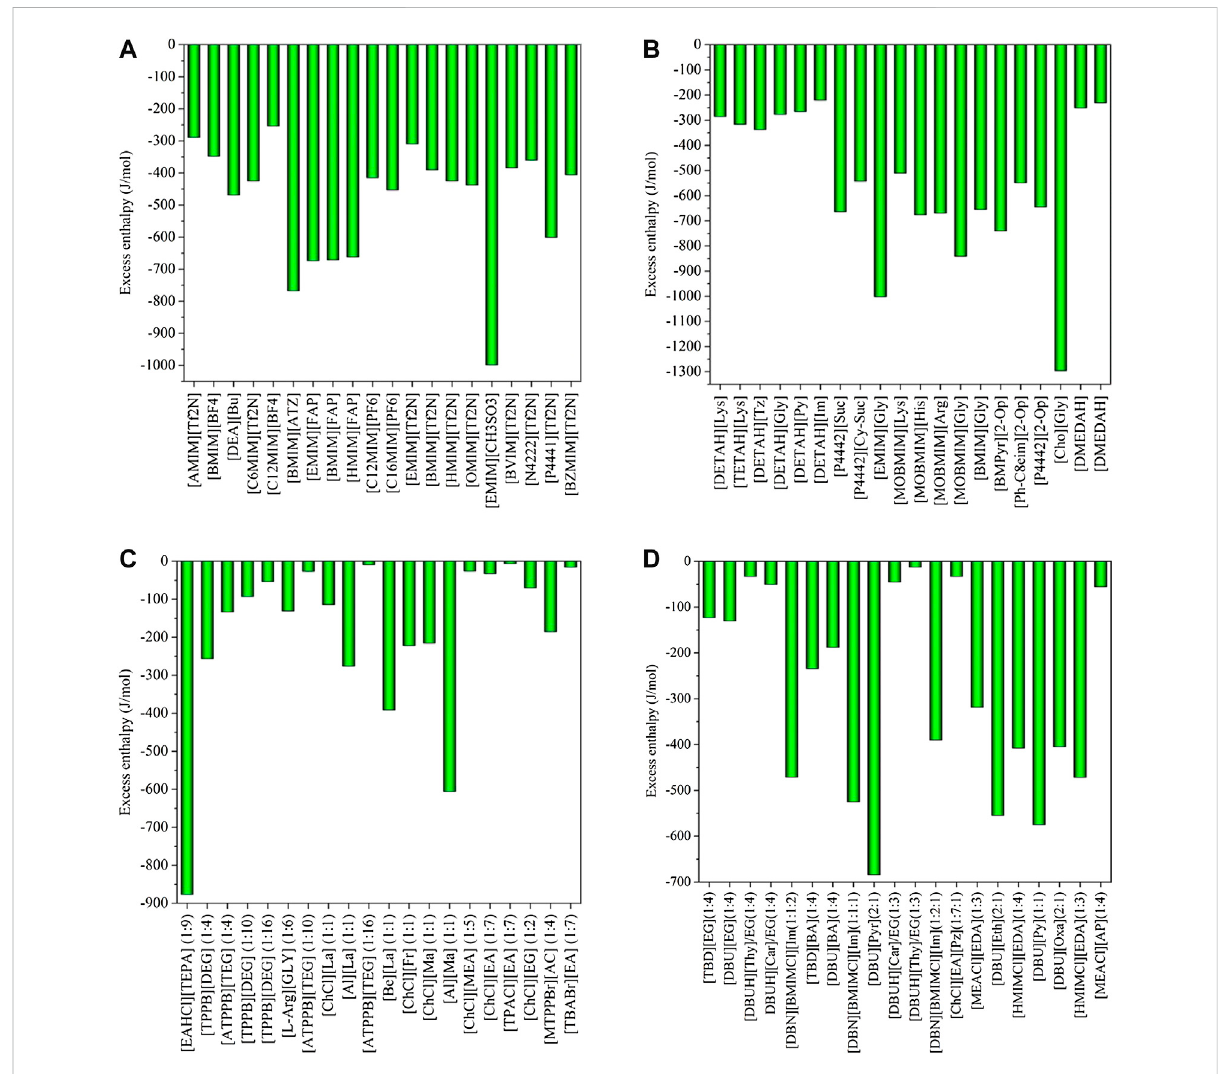
FIGURE 1 Excess enthalpies of equimolar CO 2 in physical-based ILs (A) , chemical-based ILs (B) , physical-based DESs (C) and chemical-based DESs (D) predicted by the COSMO-RS model at 298.15 (K)